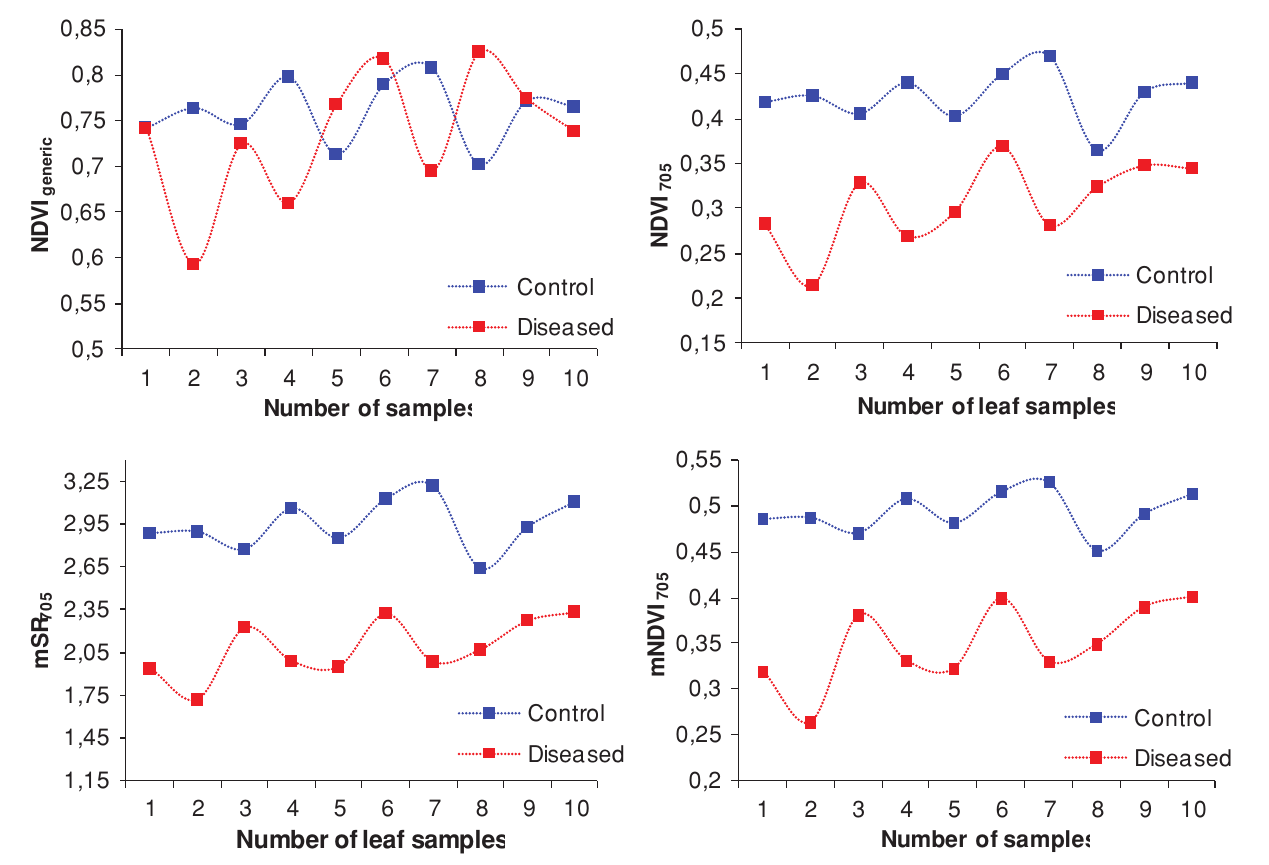
Figure 2. The calculated indices which related to the leaf chlorophyll